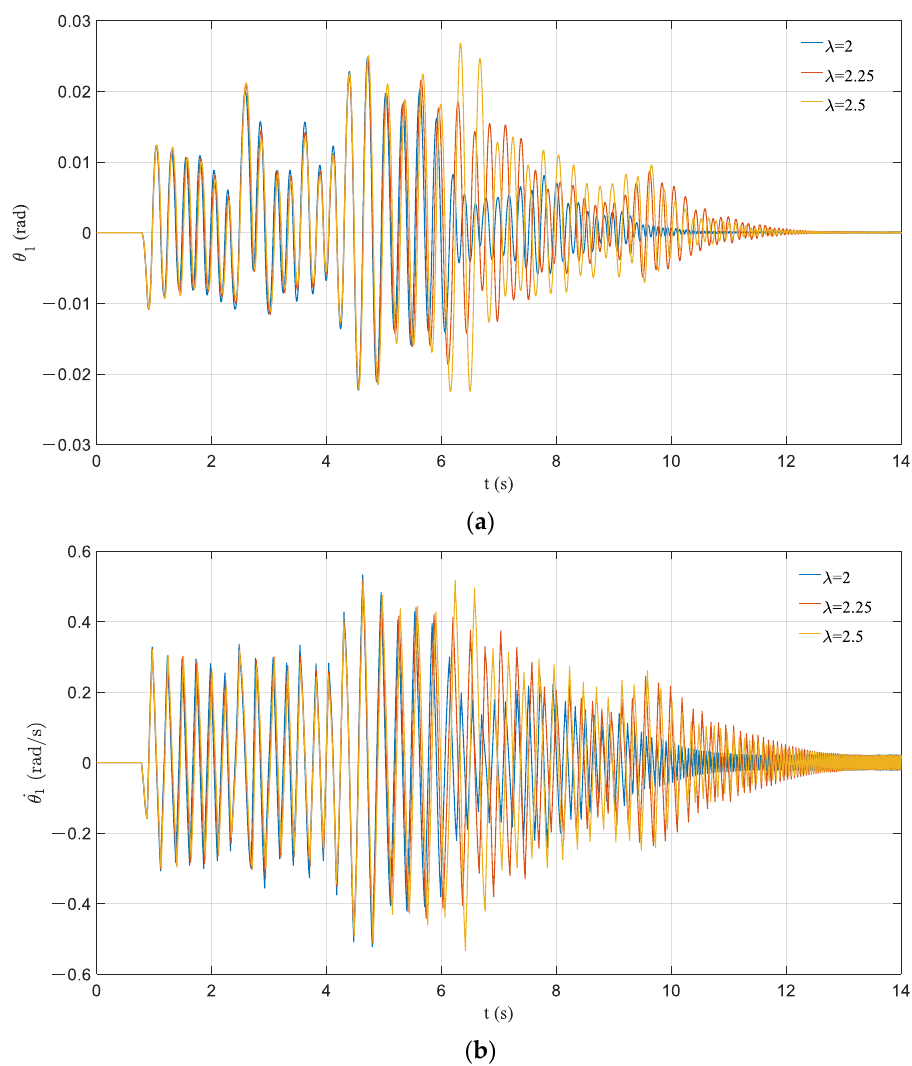
Figure 14. Effect of variation in λ : ( a ) time history of rocking rotation; ( b ) time history of angular velocity.